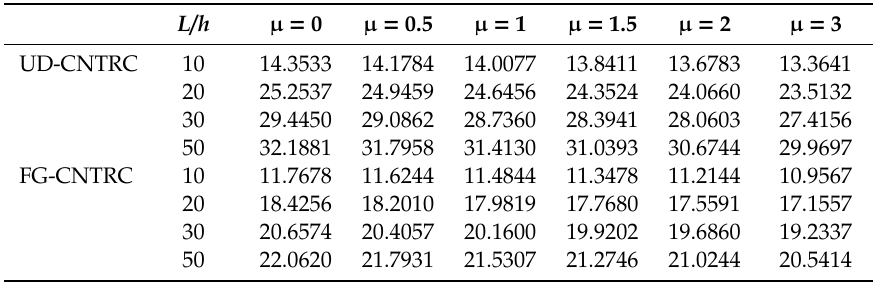
Table 6. E ff ect of the slenderness ratio L / h on the nondimensional critical buckling load for S-S CNTRC = curved beams with α = π / 3, V ∗ CNT